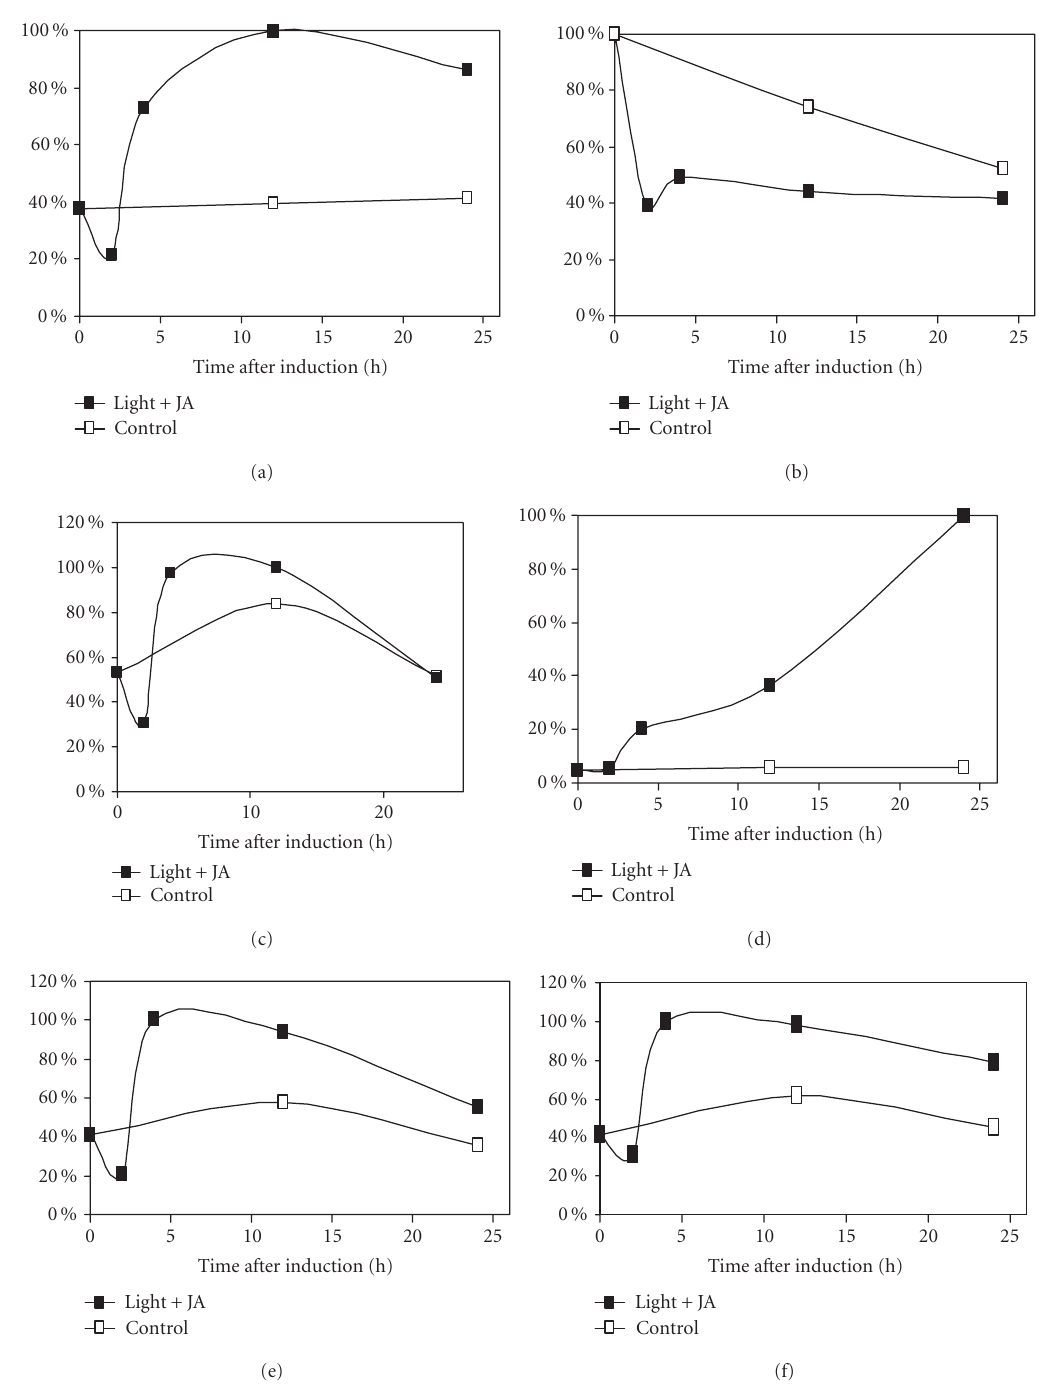
Figure 5. Quantification of mRNA level for six anthocyanin biosynthesis genes in V vinifera cell culture grown under darkness (control), and under light of 8000 Lux with JA elicitation on day 0. The RNA was probed with V vinifera cDNA clones for (a) CHS, (b) CHI, (c) F3H, (d) DFR, (e) LDOX, and (f) UFGT. Ribosomal RNA was used as an internal control. Images of Northern blot were visualized by Phosphorimager, corrected with respective rRNA, and quantified using ImageQuant